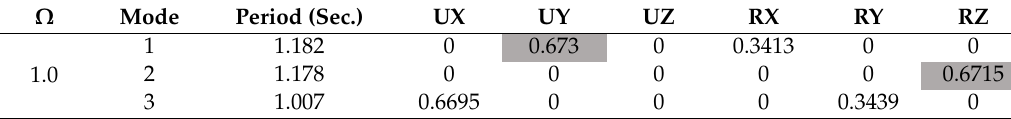
Table 3. Modal Participating Mass Ratio Buildings (with b / r = 3.28, 1 < Ty < 2 s, Ω = 1.0). Ω Mode Period (Sec.)